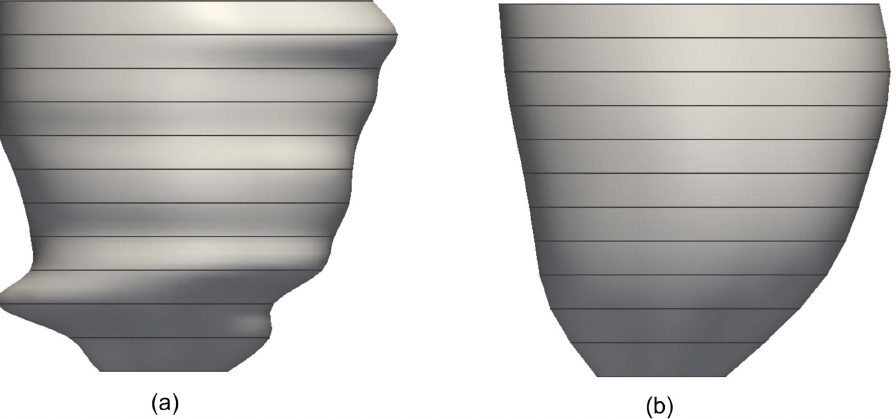
Figure 1. Three-dimensional left ventricle mesh models. (a) with motion artifacts, and (b) desired result after shape restoration.